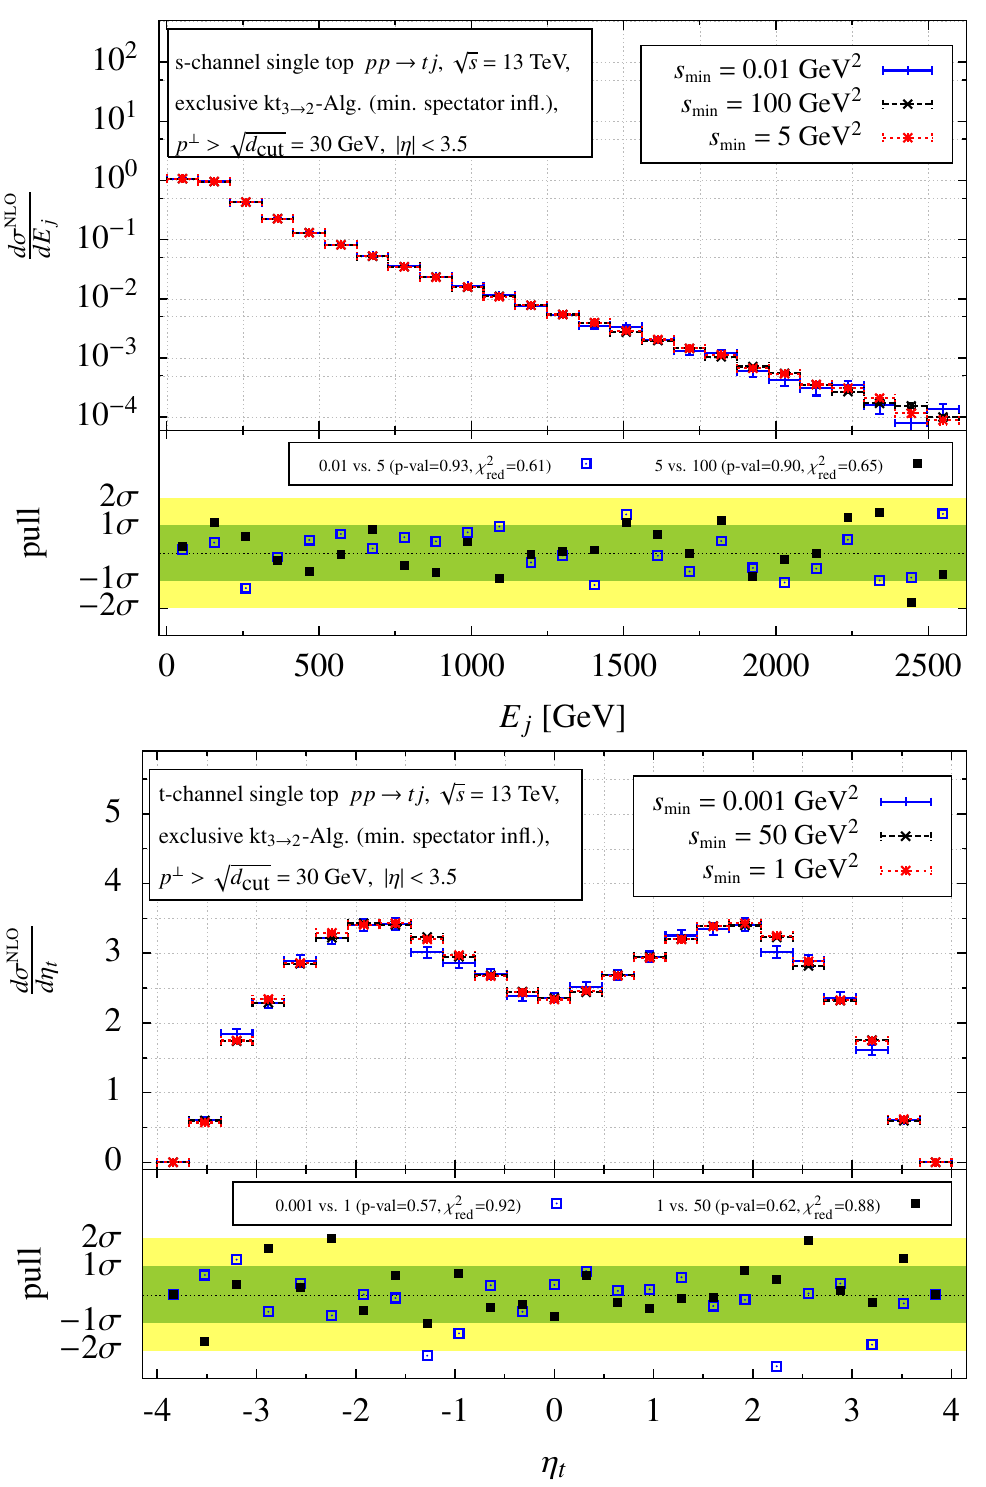
Figure 2 . Energy distribution of the light jet from s -channel single top production (upper plot) and pseudo rapidity distribution of the top-tagged jet from t -channel single top production (lower plot) for three di(cid:11)erent values of the slicing parameter s min .